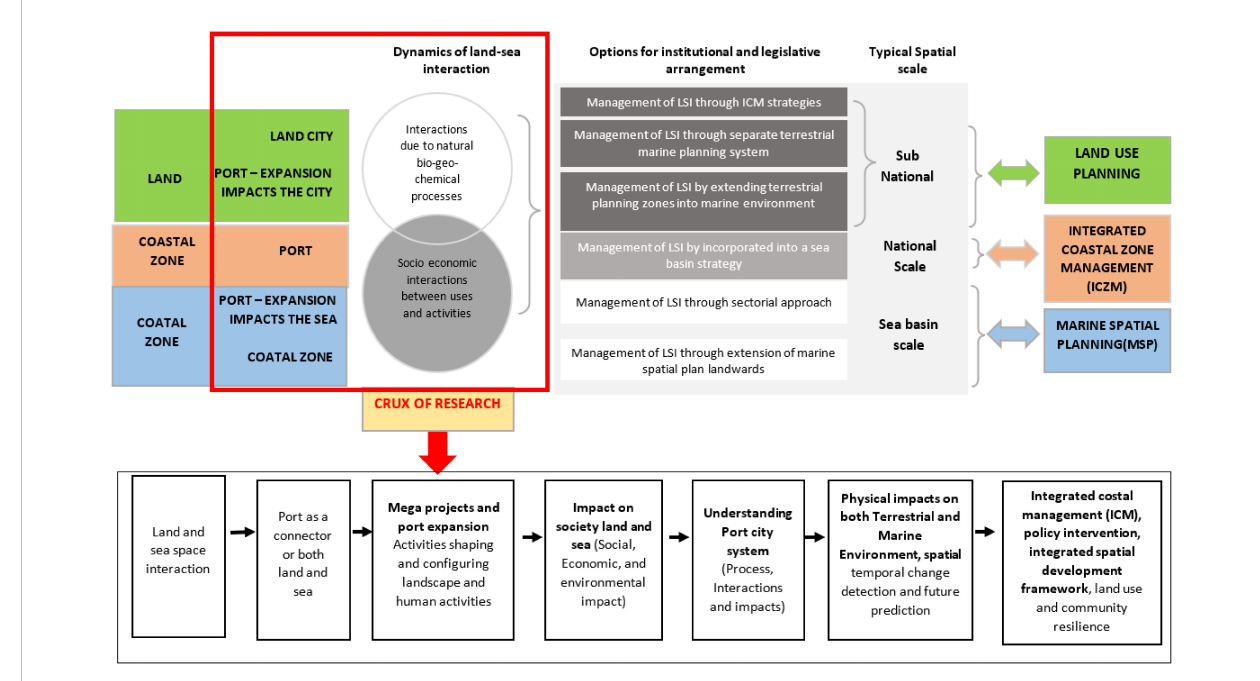
FIGURE 1 Conceptual framework of a port city in the embedded in the land and sea